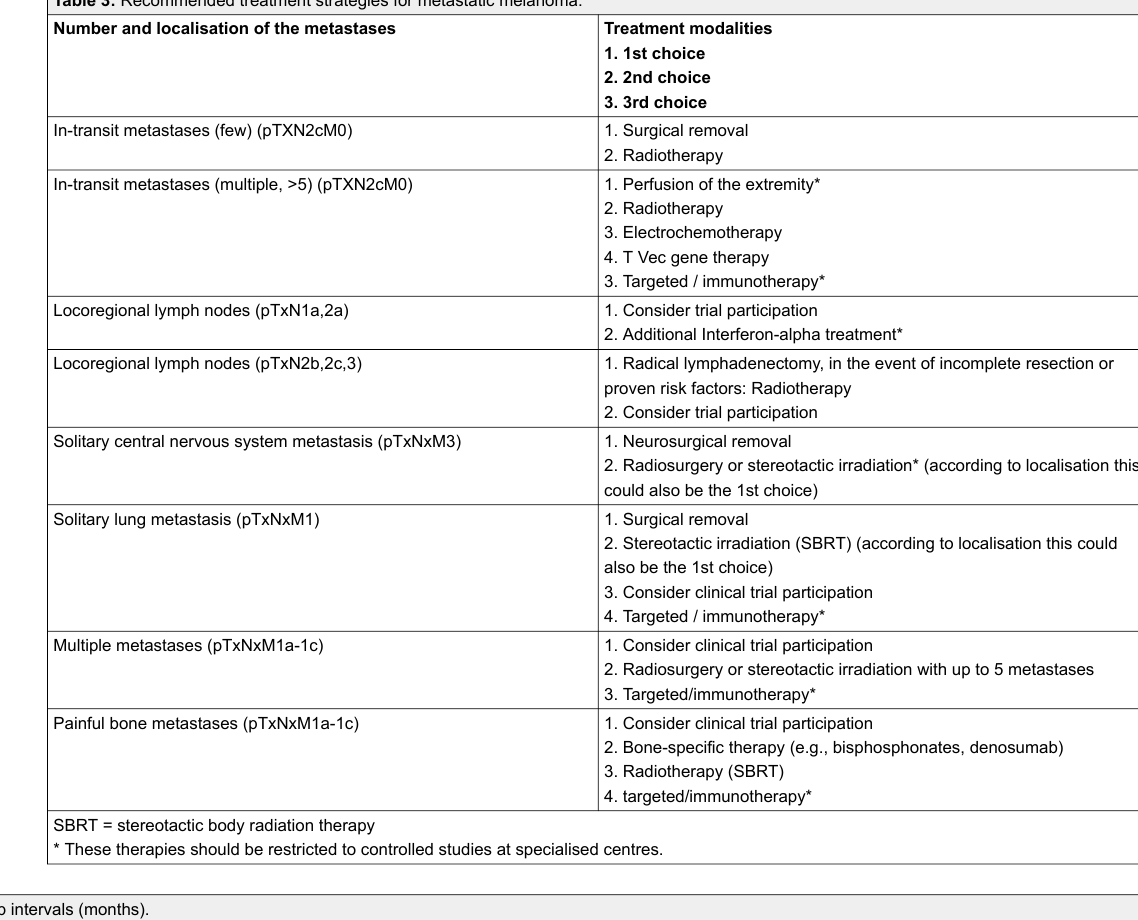
Table 3: Recommended treatment strategies for metastatic melanoma. Number and localisation of the